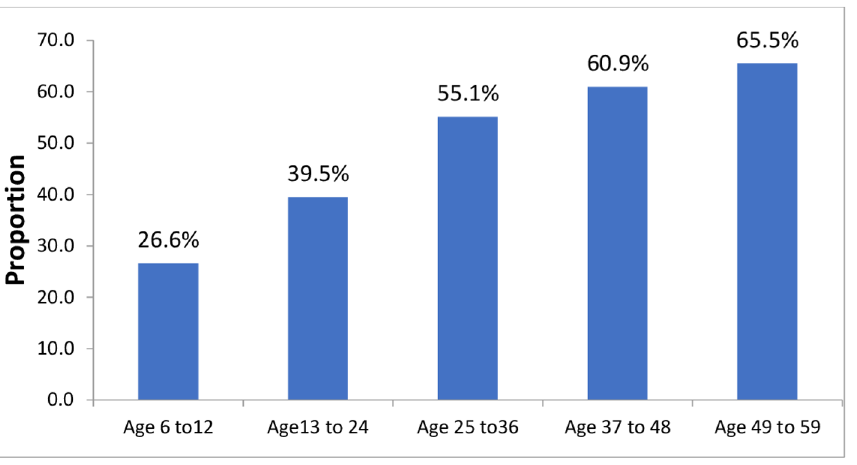
Fig 1. Prevalence of stunting by age (in months) among children aged 6–59 months at Libo-kemekem district, northwest